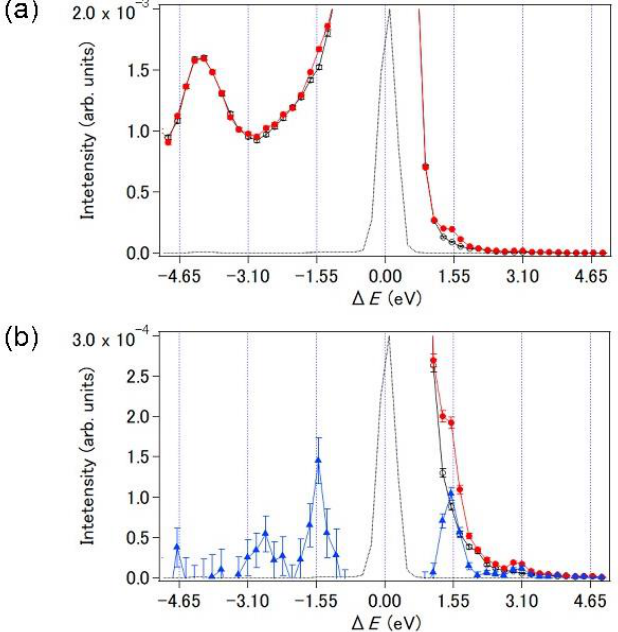
Figure 9. ( a ) The kinetic energy spectrum of the scattering intensity of electrons scattered by Ar atoms recorded with the laser pulses temporary synchronized with the electron pulses (red filled circles with error bars) and that recorded when the laser pulses pass through the scattering point 66 ps after the electron pulses (black open circles with error bars). A black dotted line represents the background electron signal intensity multiplied by 2.0 × 10 − 3 recorded without the temporal overlap. ( b ) The difference kinetic energy spectrum (blue filled triangles) obtained by subtracting the electron scattering signals without the temporal overlap between the electron and laser pulses (black open circles) from those with the temporal overlap (red filled circles with error bars). The two peaks appearing in the spectrum plotted with the blue filled triangles at ∆ E = − 1.55 and 1.55 eV represent the LAES signals at n = − 1 and +1, respectively. A black dotted line represents the background electron signal intensity multiplied by 3.0 × 10 − 4 recorded without the temporal